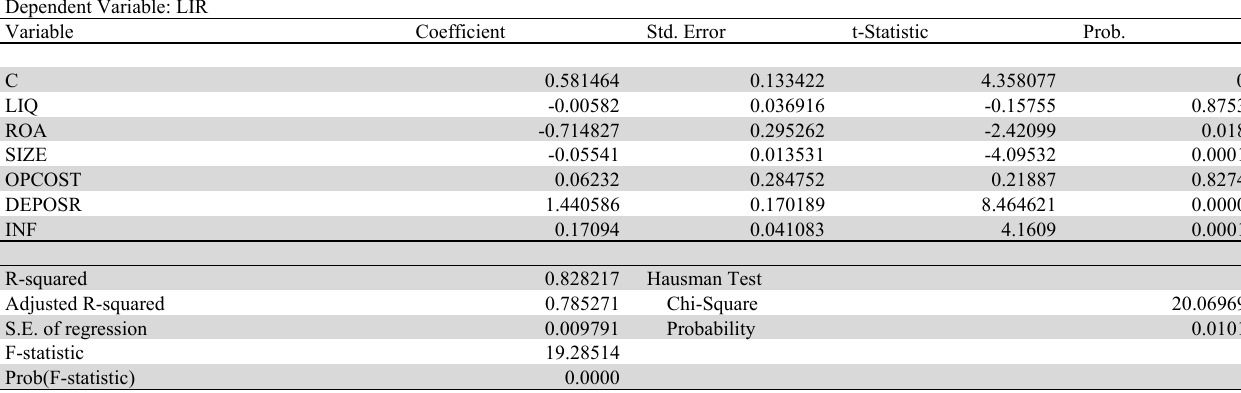
Fixed Effect Model Results